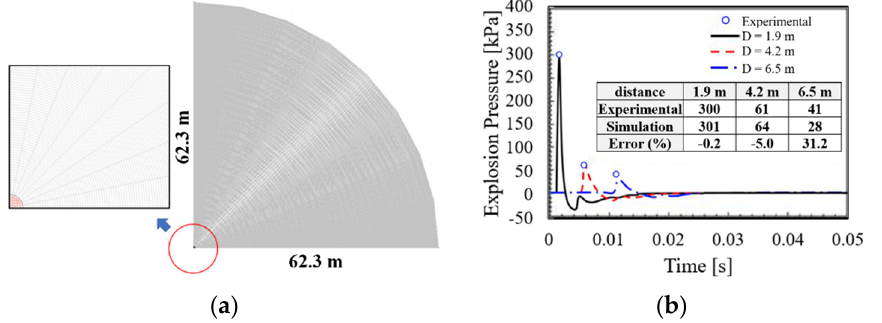
Figure 9. Verification of CFD analysis model using the open explosion condition: ( a ) numerical analysis model schematic; ( b ) comparison of simulation and experimental [7] results.